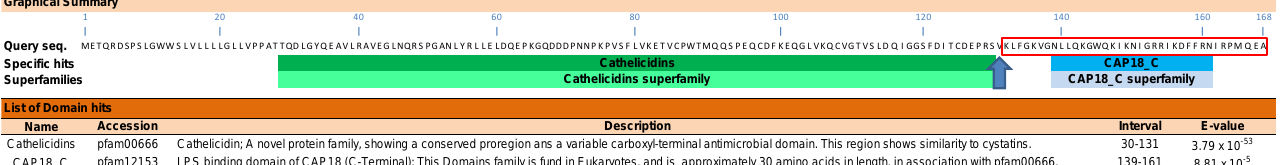
Figure 1. Graphical analysis of Talpa occidentalis cathelicidin isoform X1 (XP_037384309) when subjected to the “Identify Conserved domains” analysis tool of the NCBI protein database. The exact interval range and score (E-value) of each domain hits (pfam00666 and pfam12153) are shown in the “List of domain hits” table (below). The vertical blue solid arrow indicates the predicted position for the elastase cleaving site. The sequence of the antimicrobial portion of the putative peptide for the cathelicidin of Talpa occidentalis is within the red